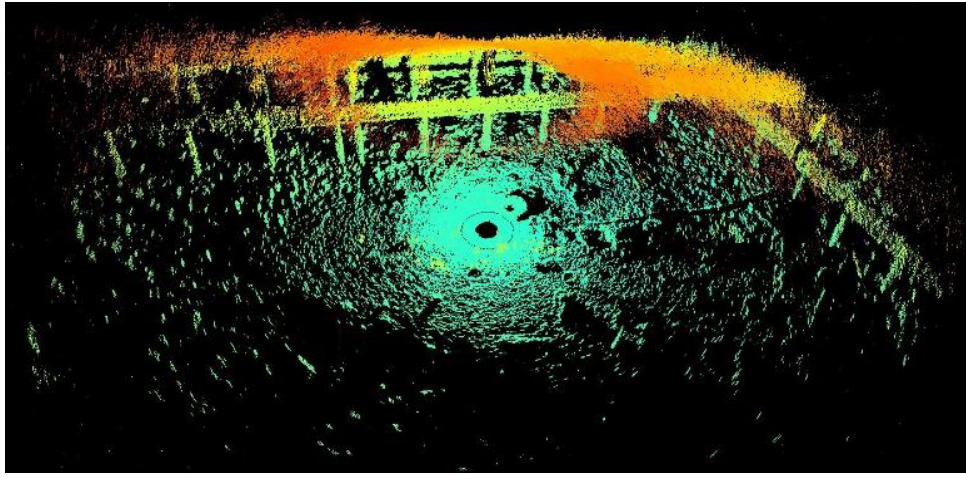
Figure 1. Raw data obtained from the BV5000.